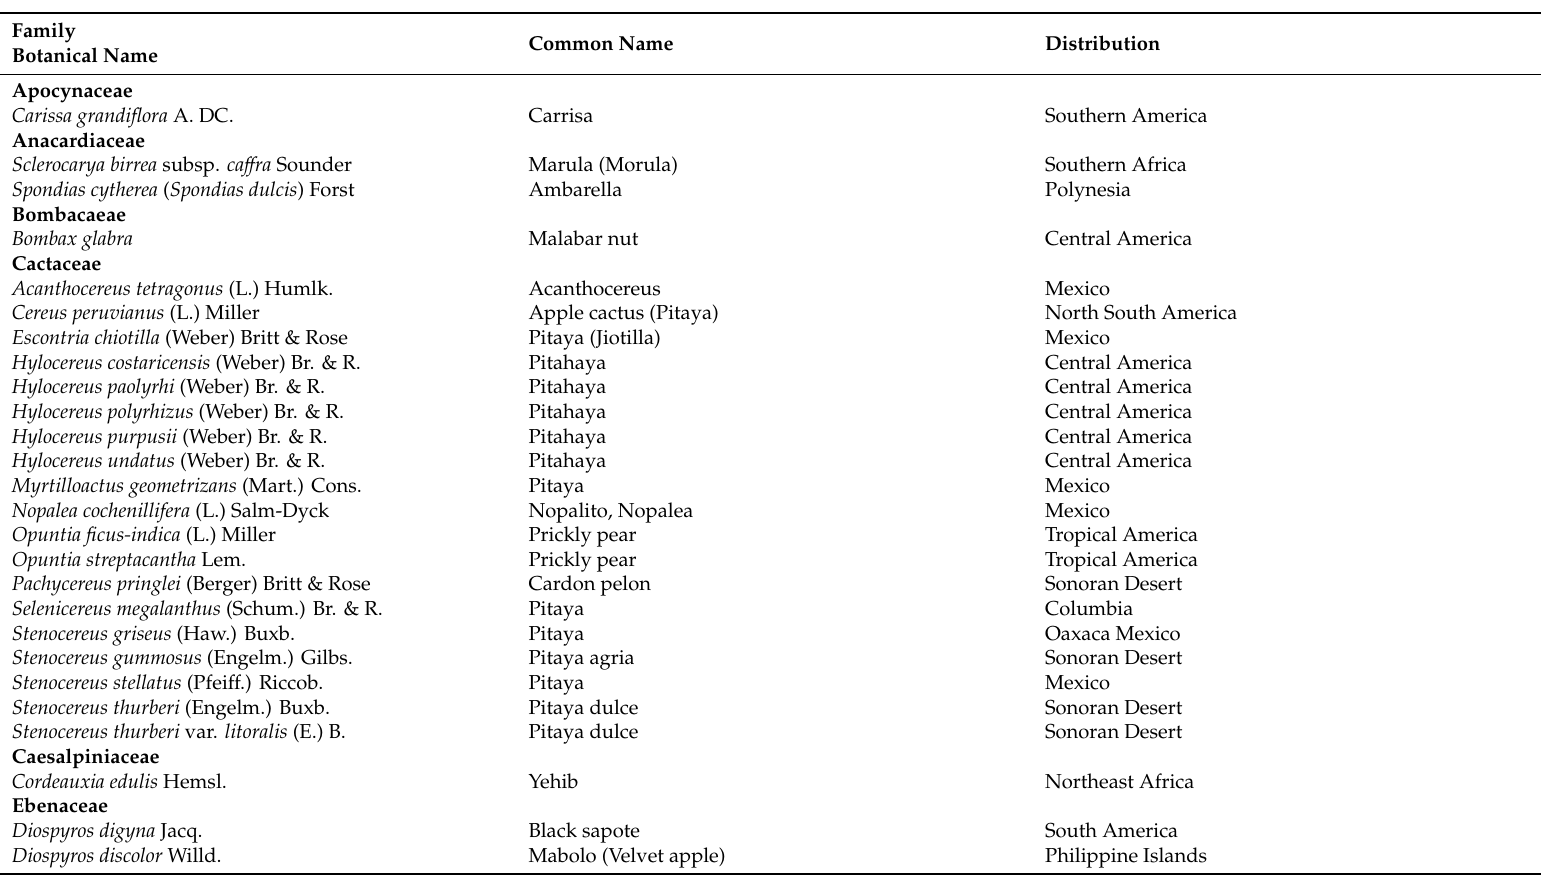
Table A1. Full list of our candidate